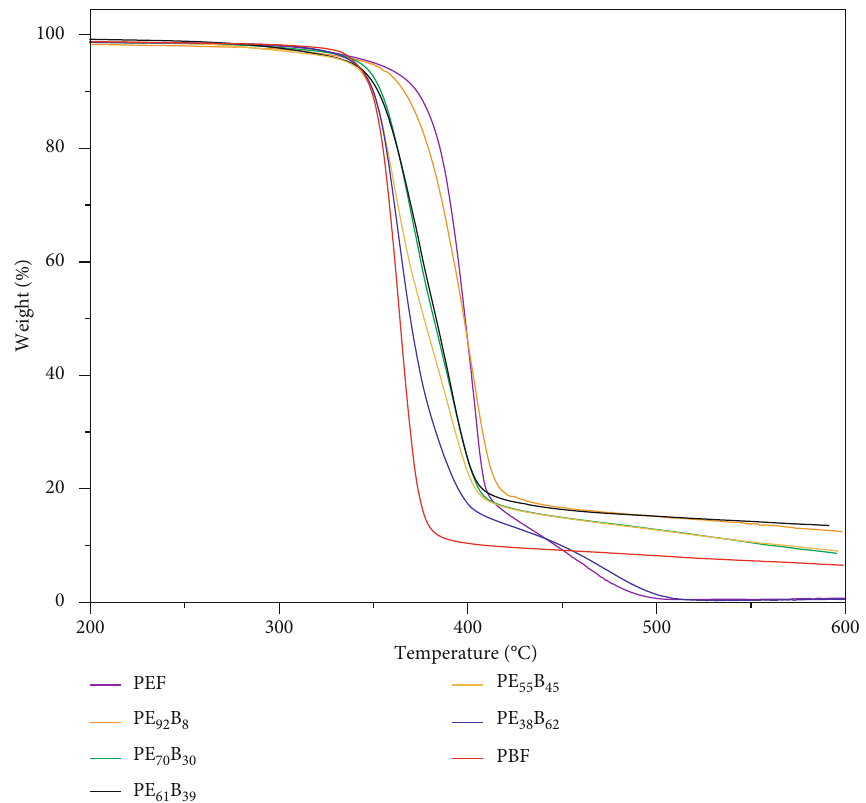
Figure 5: TGA plots of PEF, PBF, and